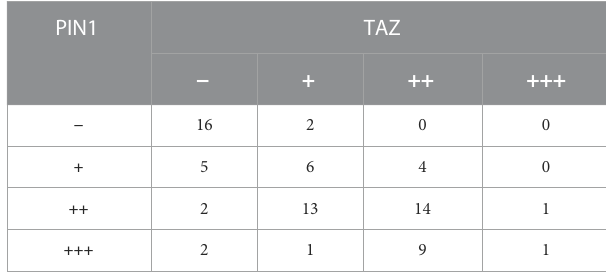
TABLE 2 The correlation of PIN1-TAZ was analyzed after IHC results were